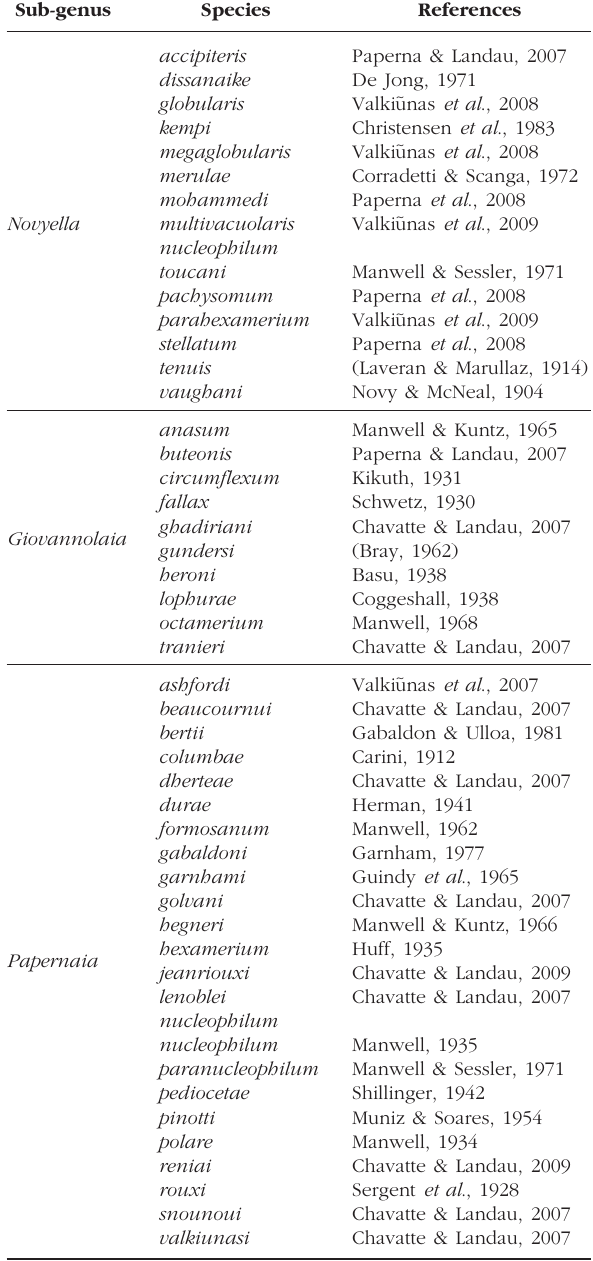
Table II. – Checklist of Plasmodium sub-genera and assigned